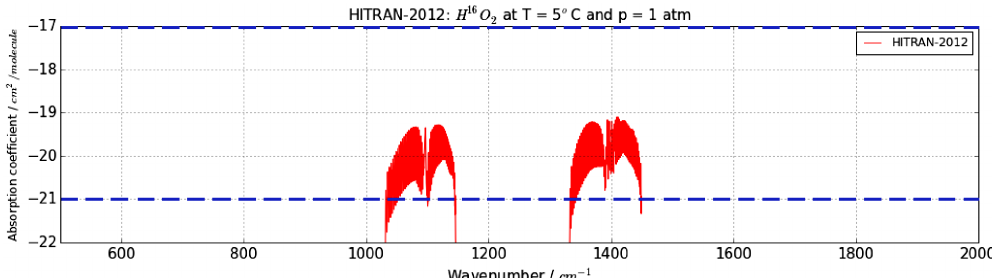
Figure 5. Cross sections generated from the HITRAN data for HO 2 . The area inside the thick dashed horizontal grid lines corresponds to the area shown in the panels of Fig. 1 in the BG